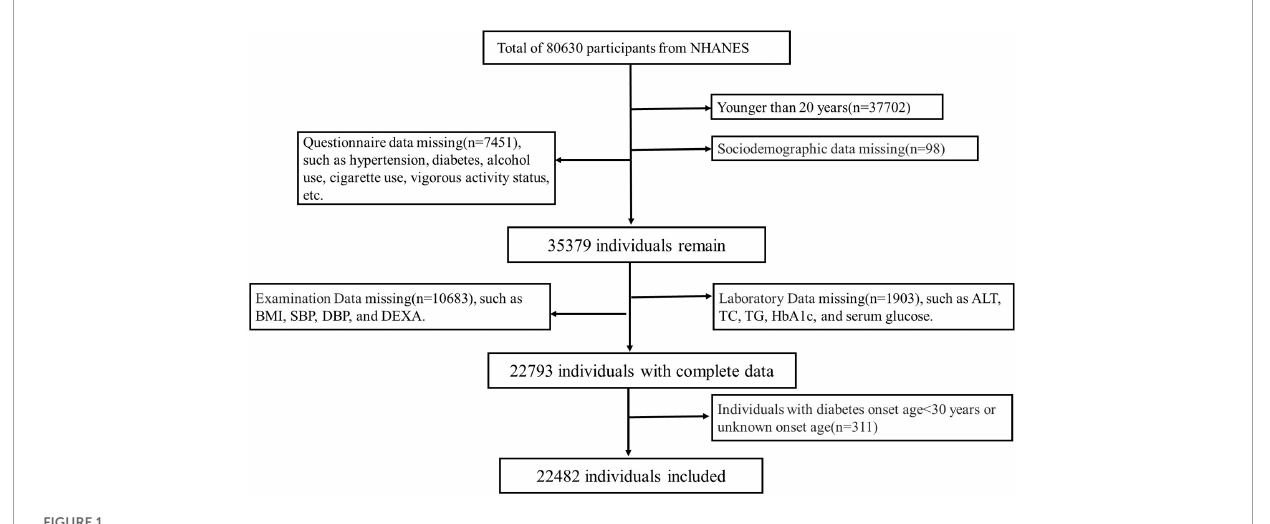
FIGURE1 Flow chart of participants included in the